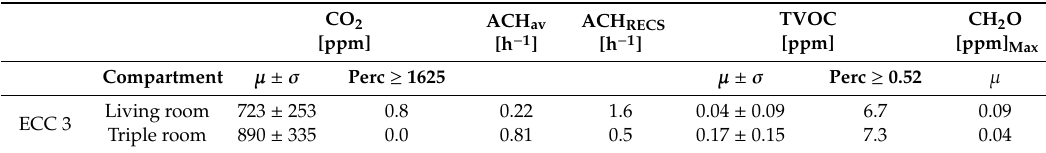
Table 14. Statistical analysis of the pollutants recorded in ECC 3 compartments and calculation of ACH: 2 nd trial